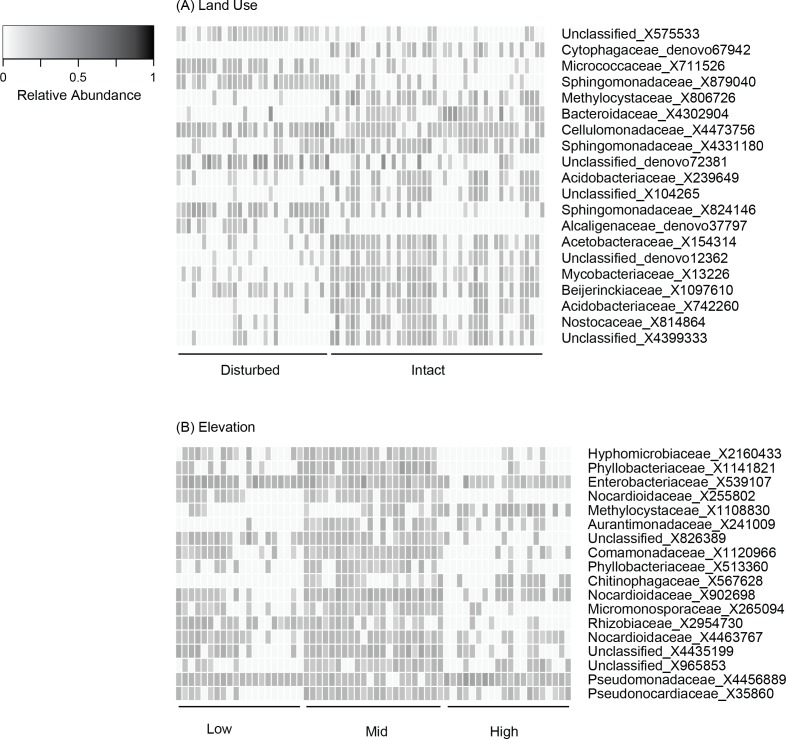
Relative abundance of OTUs selected based on K–S measures that best defined the differences in skin bacterial community structure of Eleutherodactylus coqui across (A) land use types and (B) elevations.OTU relative abundances ranged from 0 to 0.29. Lighter shades indicate lower relative abundances (white relative abundance = 0) and darker shades indicate higher relative abundances (darkest relative abundance = 0.29). OTUs are ordered top to bottom based on K–S measures (see Tables 4 and 5 for values and additional taxonomic information for each OTU).